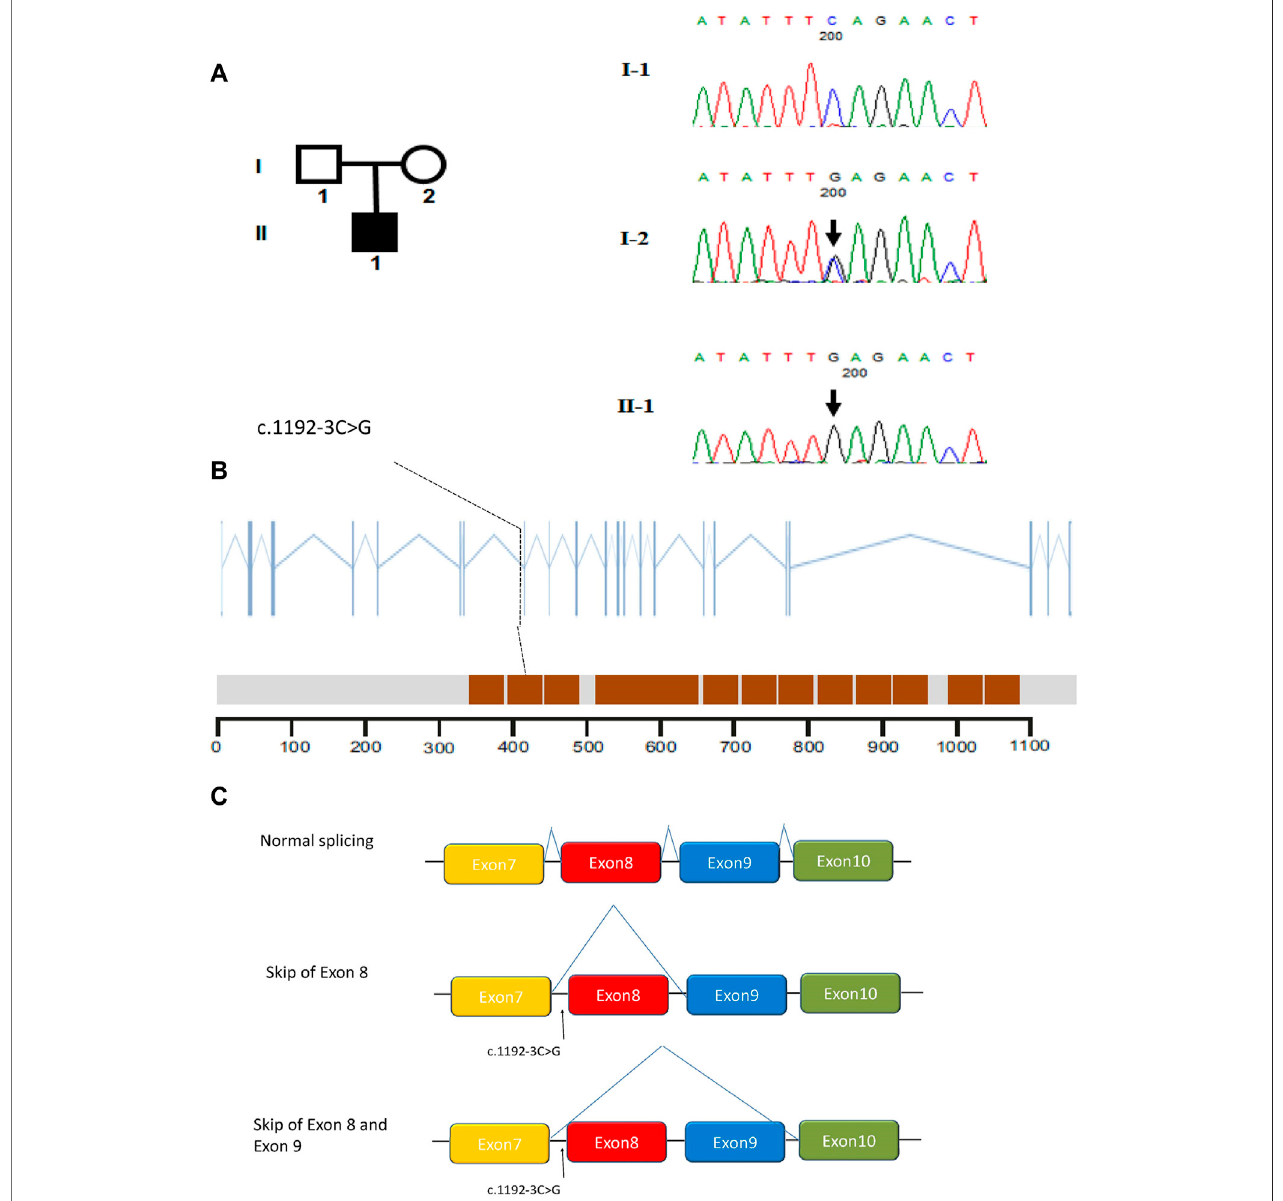
FIGURE 2 | Identi fi cation of intronic variant of CFAP251 in men with MMAF. (A) The pedigree of the family showing the father (I-1) and mother (I-2) with their offspring numbered II-1; black- fi lled squares indicate the male individuals with MMAF. Sanger sequencing results are shown below the pedigrees. The variant positions are indicated by black arrows. (B) The positions of the intronic CFAP251 mutation are indicated in the CFAP251 gene and the protein domains of CFAP251 . The brown squares in the picture represent WD repeat domains. (C) Schematic representation of the impact of the splicing variant on mRNA